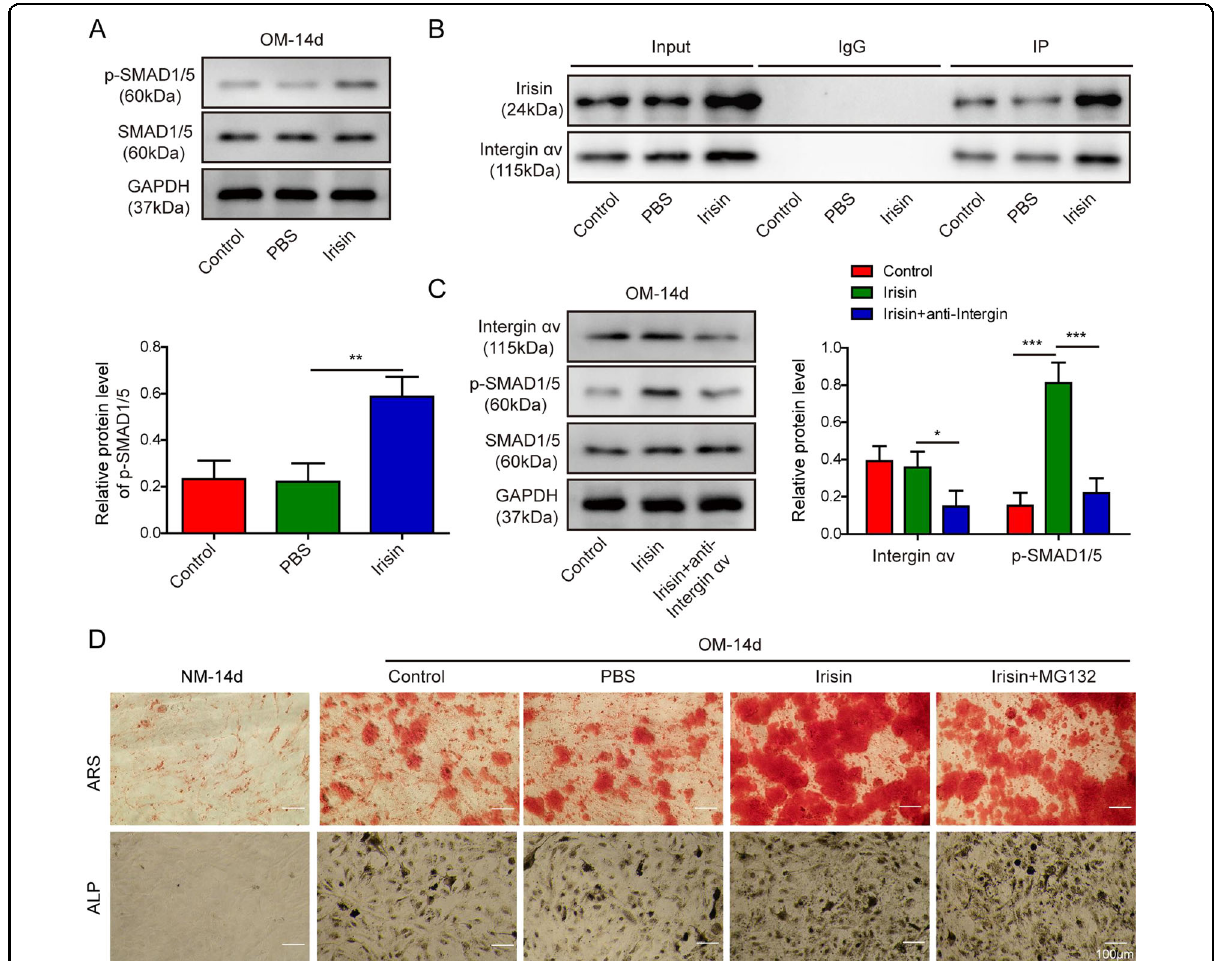
Fig. 6 Irisin-mediated osteogenic differentiation in BM-MSCs through speci fi c binding with Integrin α V and activation of the SMAD1/5 pathway. A BM-MSCs were transfected with pcDNA3.1 vector containing Irisin and further cultured in OM for 14 days. WB was performed to analyze the expression of SMAD1/5 and phosphorylated SMAD1/5. B Intermolecular interaction between Irisin and the transmembrane receptor Integrin α V was tested by Co-IP. C BM-MSCs were transfected with Irisin-overexpressing pcDNA3.1 vector alone and further cultured in OM containing Integrin α V speci fi c antibody for 14 days. WB was performed to measure the expression of Integrin α V, SMAD1/5, and phosphorylated SMAD1/5. D ARS and ALP staining assays were performed to evaluate the osteogenic differentiation in Irisin-overexpressing BM-MSCs and those treated with MG132. The data were shown as mean ± SD based on at least three independent experiments. * P < 0.05, ** P < 0.01, and *** P <